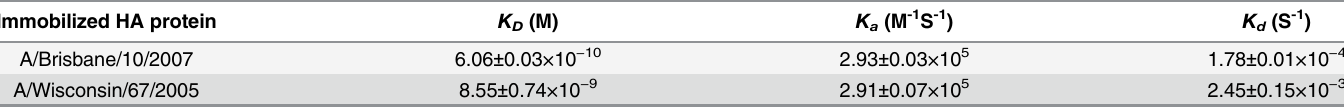
Table 1. Affinity constants ( K a , K d ) of CT302 IgG 1 determined by real-time interaction analysis. Immobilized HA protein